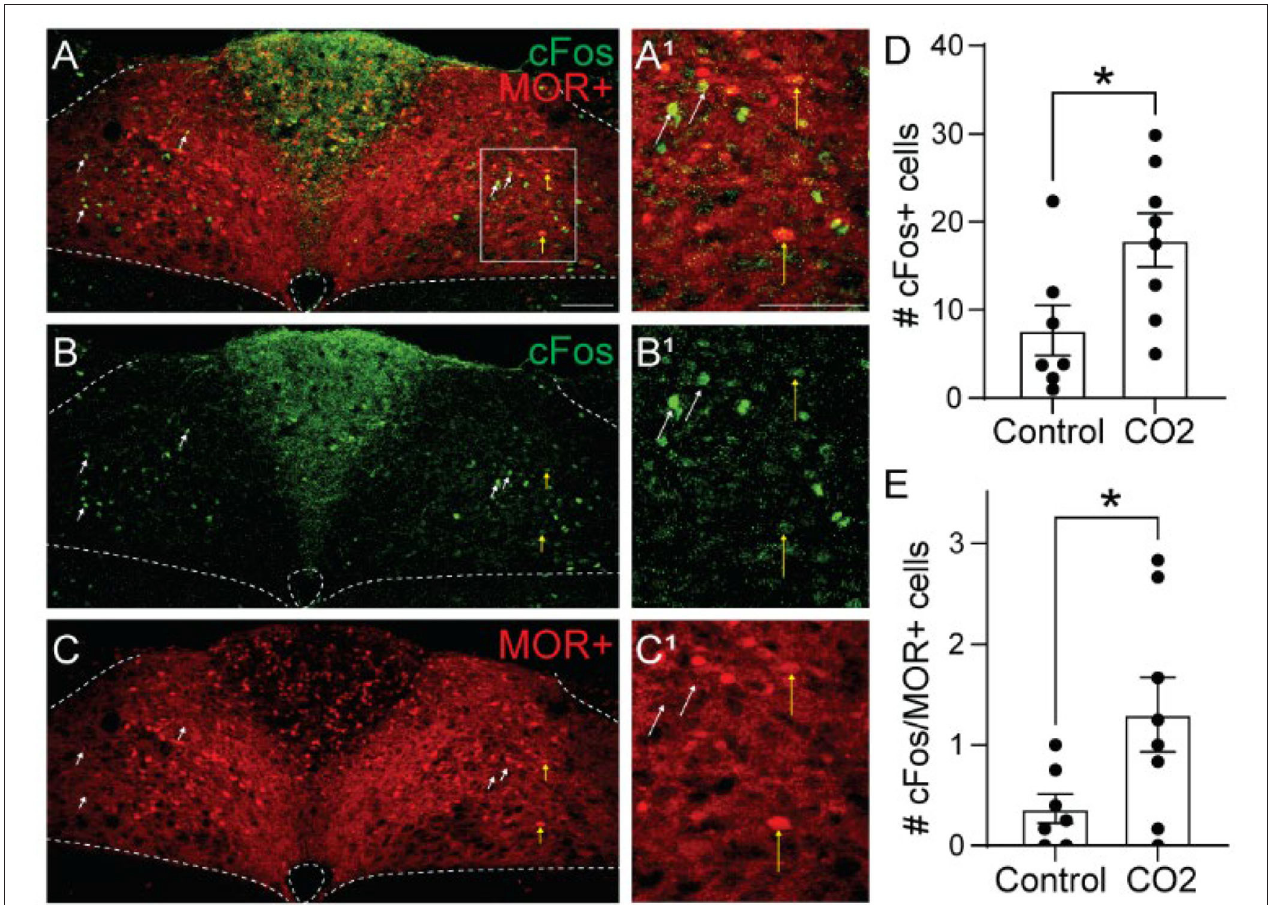
FIGURE 3 | Hypercapnia activates MOR-negative neurons. Identification of cFos immunolabeling and tdTomato expression, as an indicator of MOR expression, in the NTS of Oprm1 Cre / tdT mice that were exposed to standard air (Control) or hypercapnic air (7% CO2). (A–C) Example images of cFos immunostaining (green) and MOR + tdTomato expression (red) from a mouse exposed to hypercapnia. Very few cells co-expressed cFos and tdTomato (indicated by yellow vertical arrows). White diagonal arrows are pointing at example cells that are cFos + , but do not express MORs. (A 1 –C 1 ) are zoomed in views of the boxed region in (A–C) . Scale bar = 100 µ m. (D,E) Summary data of the average number of cFos + NTS cells per section (D) , or the average number of co-labeled cFos + /MOR + NTS cells per section (E) ( n = 7–8 mice/group, 2–6 sections/mouse). Each data point represents the average # of cFos + cells per section for an individual mouse. Bar and error are group mean ± SEM. * p < 0.05 by unpaired t-